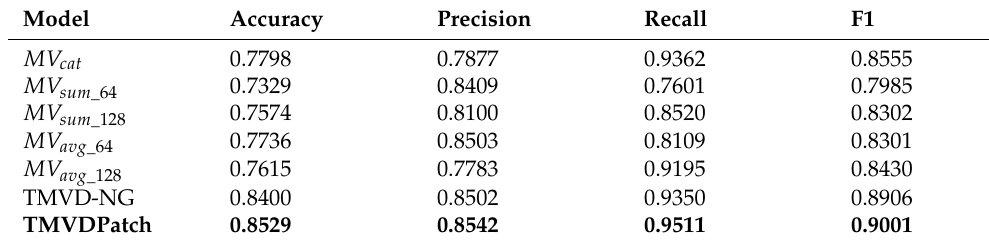
Table 4. The results of different ensemble